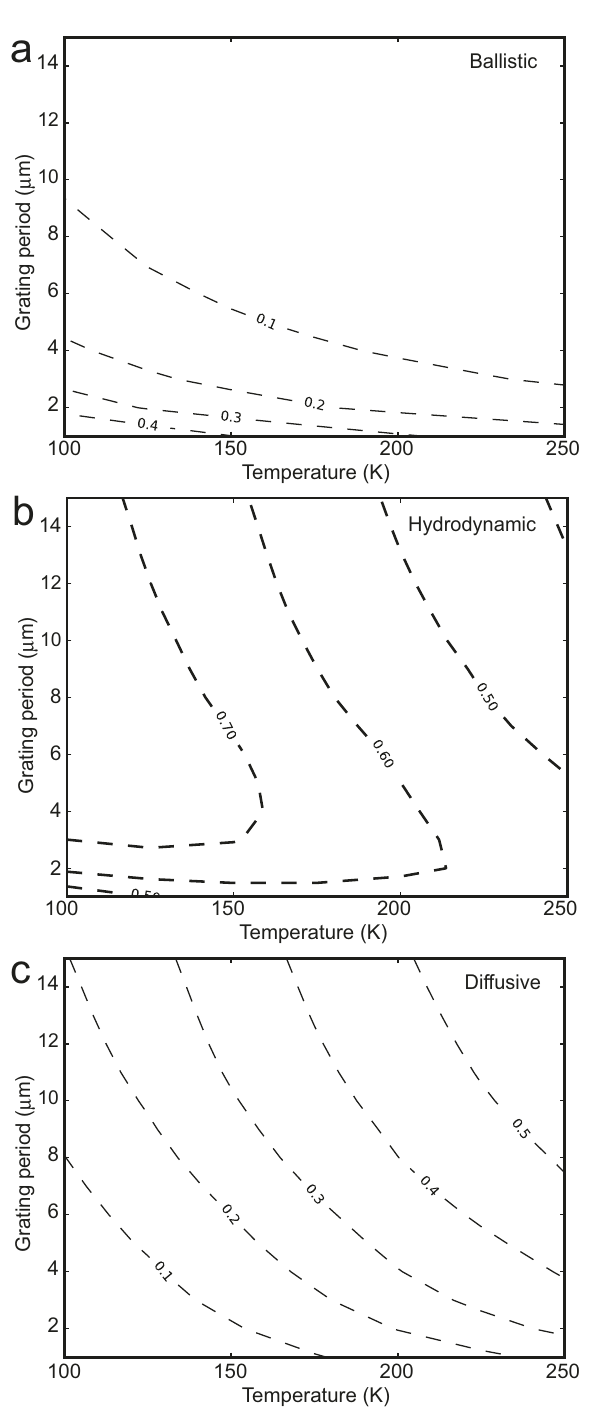
Fig. 3 The three groups of phonons. Approximated fraction of excited phonons in the ( a ) ballistic, ( b ) hydrodynamic, and ( c ) diffusive regime based on Eq.